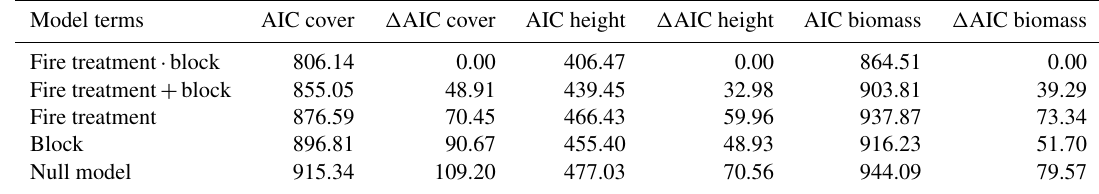
Table 2. Linear mixed model results of lidar-estimated canopy cover, mean height, and above-ground woody biomass. Model